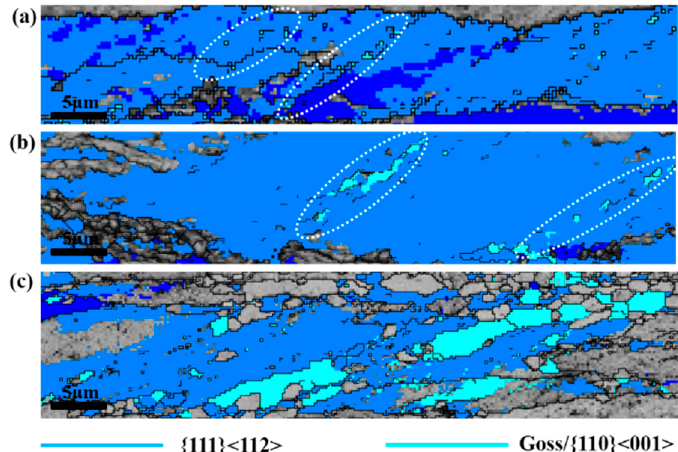
Figure 5. Nucleation of shear bands: ( a ) Goss subgrains at initial microstructure, ( b ) Goss subgrain coalescence at 660 °C and ( c ) Goss recrystallization at 680 °C .